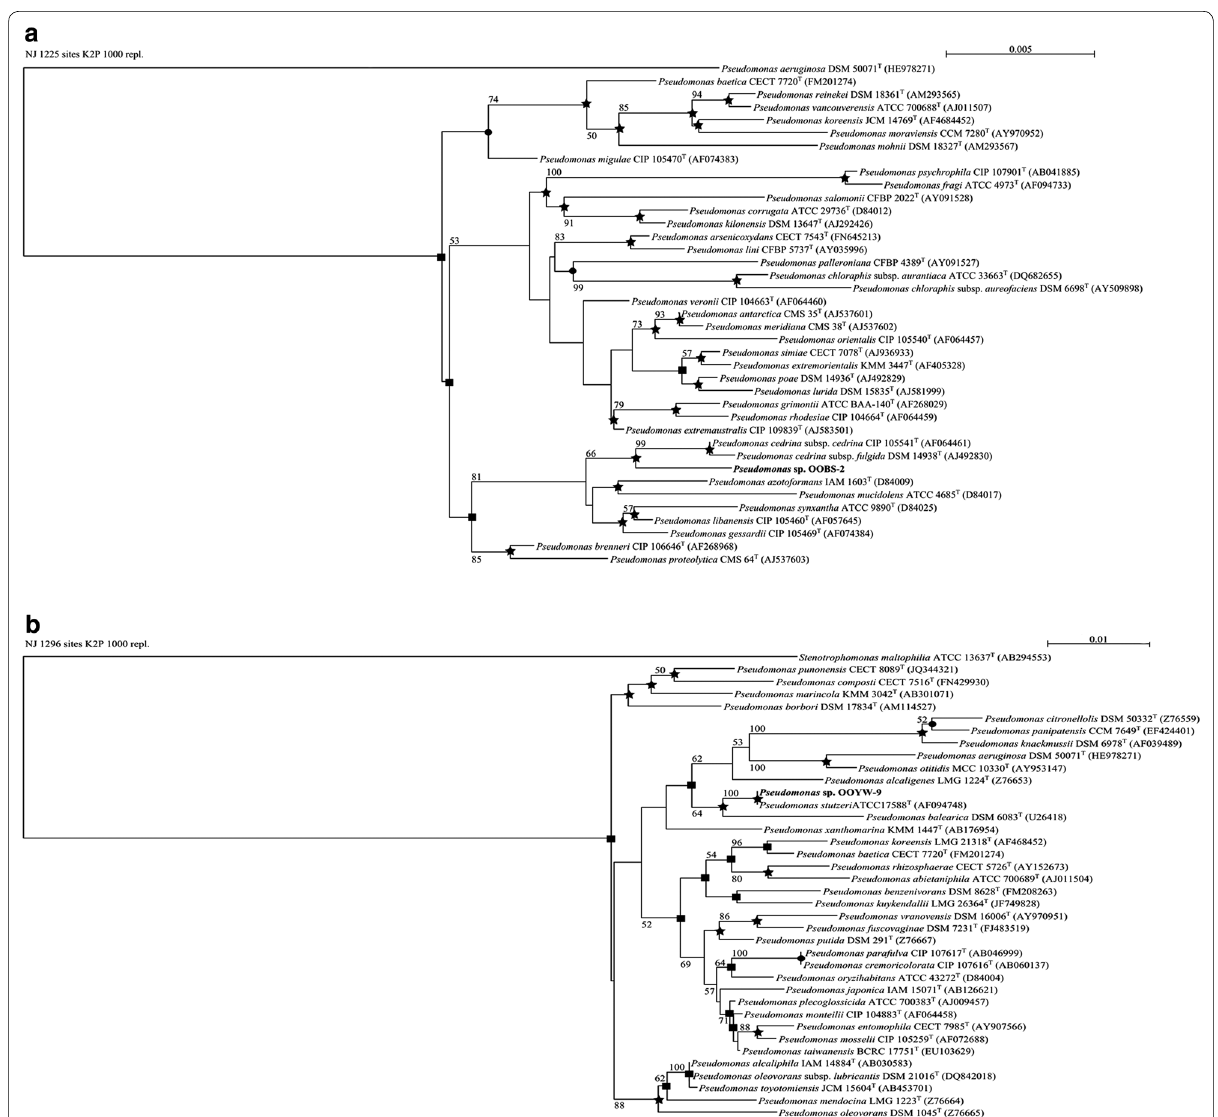
Fig. 2 NJ phylogenetic tree based on 16S rRNA gene sequences showing the positions of Pseudomonas sp. OOBS-2 ( a ) and Pseudomonas sp. OOYW-9 ( b ) and some other related taxa. Bootstrap values (expressed as percentages of 1000 replicates) of Filled circle, filled square, star indicate that the corresponding nodes were also recovered in trees constructed using MP, ML, and both algorithms, respectively. Pseudomonas aeruginosa DSM 50071 T and Stenotrophomonas maltophilia ATCC 13637 T were used as outgroups in a and b respectively. Bar, 0.005 and 0.01 substitutions per nucleotide